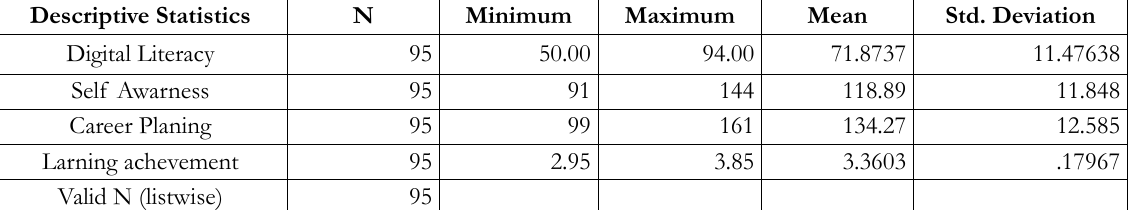
Table 1. Description of research data